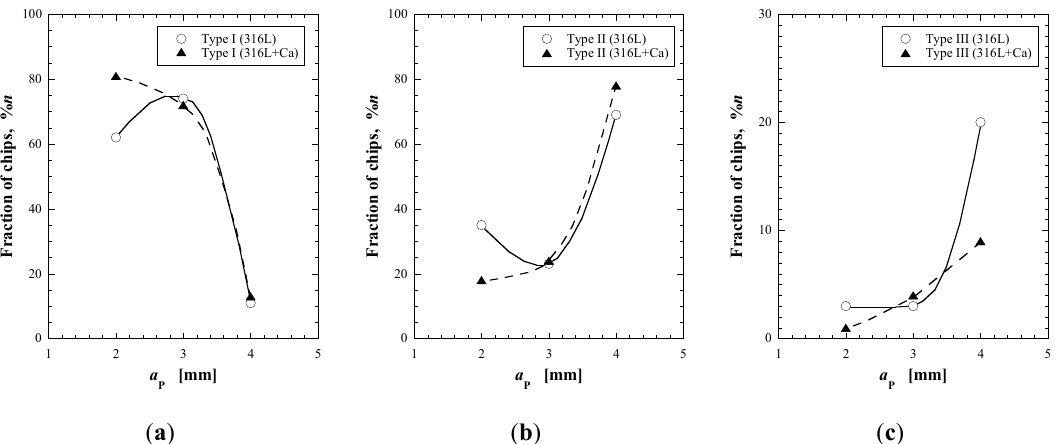
Figure 6. Chip weight distributions for Type I ( a ), Type II ( b ), and Type III ( c ) chips obtained at an f n value of 0.5 mm/rev and a cutting speed of 130 m/min.